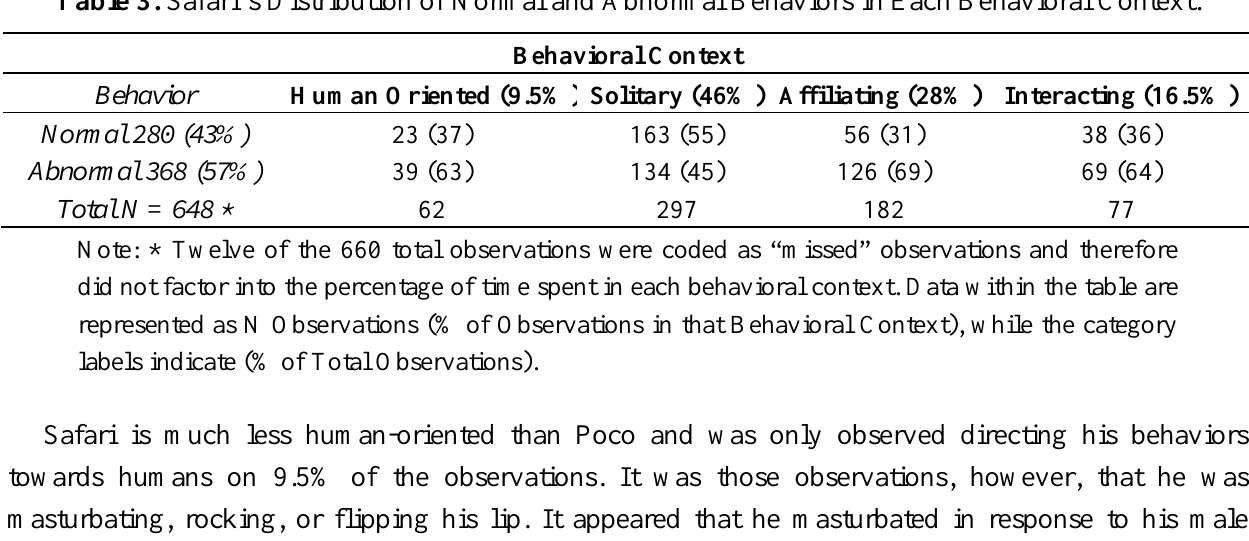
Table 3. Safari’s Distribution of Normal and Abnormal Behaviors in Each Behavioral